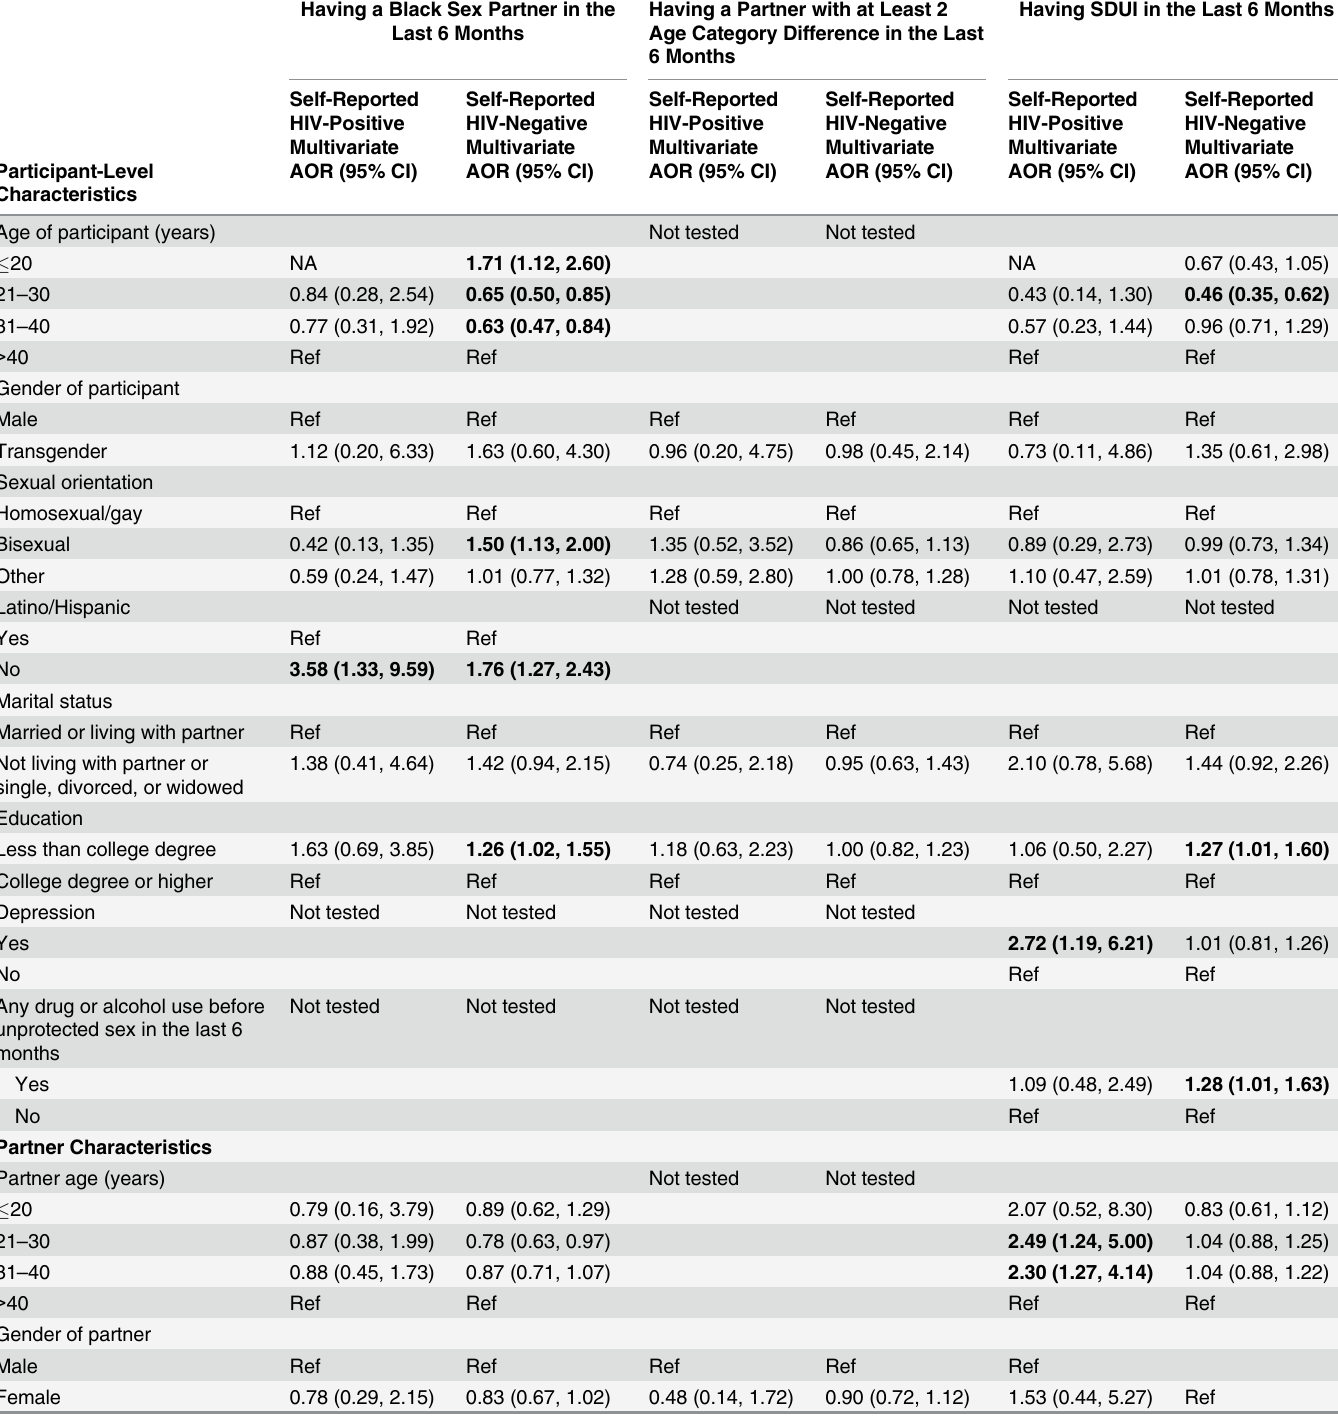
Table 3. Participant and Sex Network Characteristics Associated with Having a Black Sex Partner, Having a Partner with at Least 2 Age Category Difference, and Having SDUI in the Last 6 Months among Community-Recruited Participants Stratified by Self-Reported HIV Serostatus of Partici- pant, Multivariate GEE Models (N = 4,449